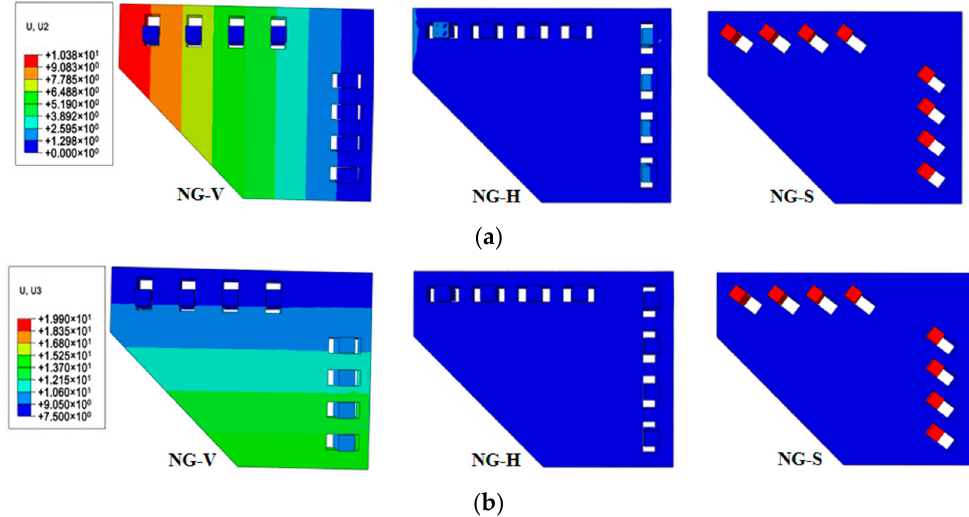
Figure 12. The ( a ) vertical and ( b ) horizontal displacement contours of specimens NG- V , NG-H and NG-S.